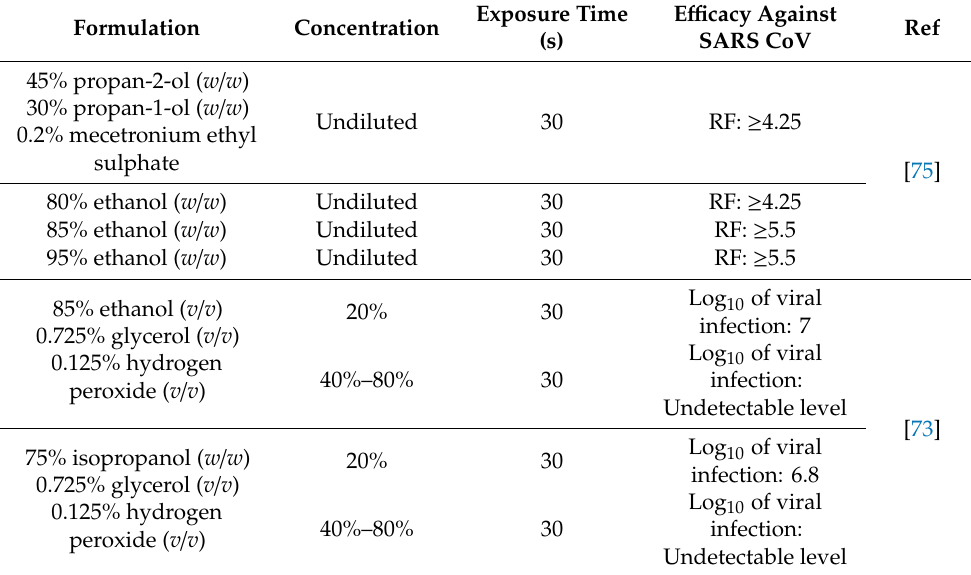
Table 5. E ffi cacy of di ff erent types of alcohol-based sanitizers at various concentrations against severe acute respiratory syndrome (SARS)